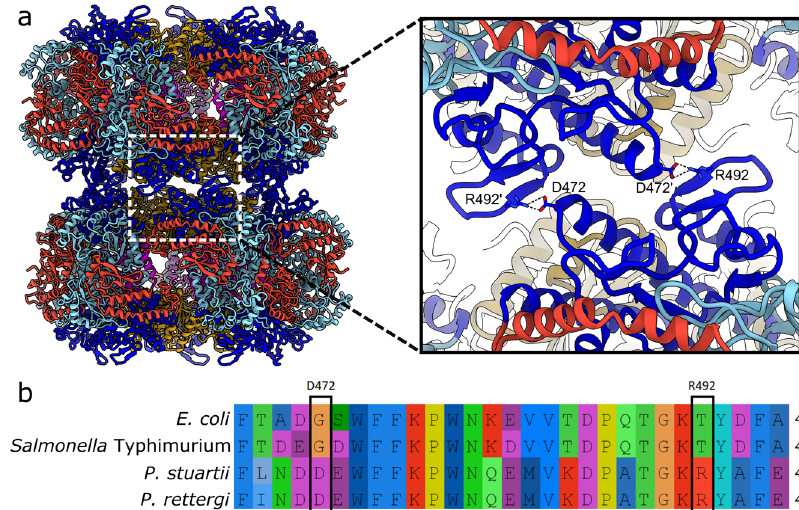
Fig. 2 Molecular determinants of Adc stack formation. a Atomic model of a 2-decamer stack shown as cartoons, with domains coloured as in Fig. 1a. The inset shows a closeup of the decamer:decamer interface in the stack, with the key stack-forming residues D472 and R492 shown as sticks. b Multiple sequence alignment of Adc sequences from E. coli (WP_001381593.1), Salmonella Typhimurium (WP_000978690.1), P. stuartii (WP_004923888.1) and P. rettgeri (WP_164564359.1) focused on region around key stack-forming residues D472 and R492 in the P. stuartii Adc (indicated by boxes), coloured according to the AliView colour